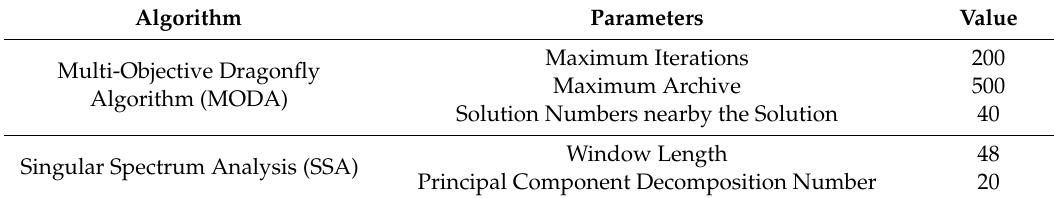
Table 6. Parameters in experiment 3.